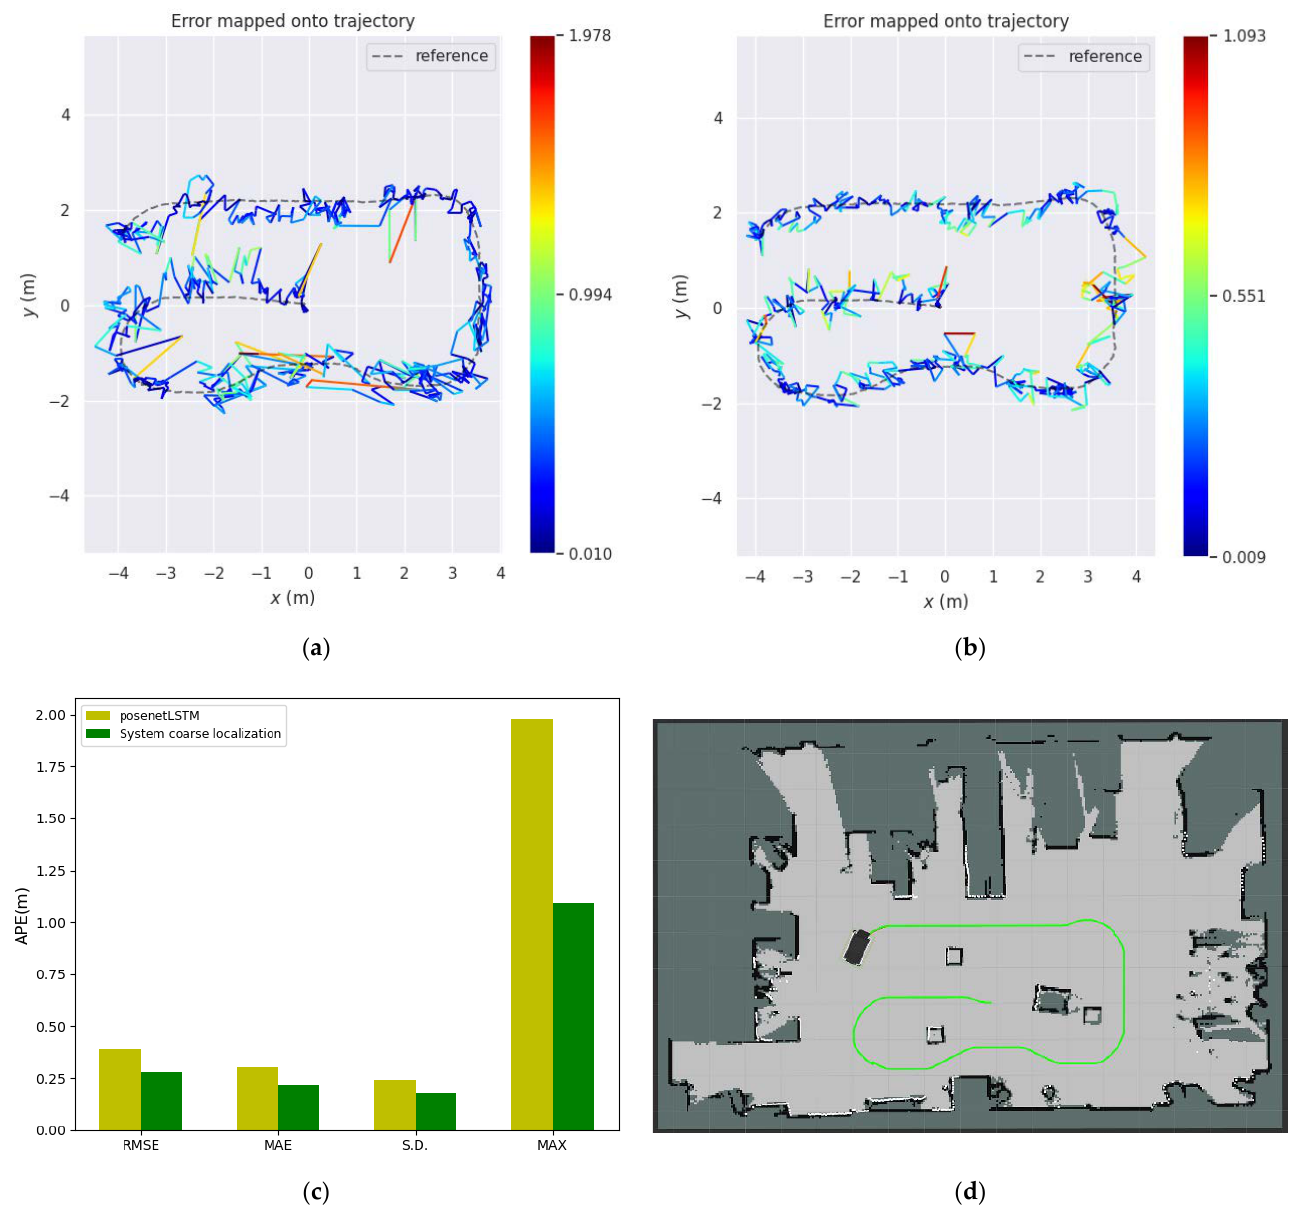
Figure 15. ( a ) Absolute pose error of posenetLSTM; ( b ) Absolute pose error of the proposed neural network; ( c ) Statistics of absolute pose error; ( d ) The robot’s trajectory.